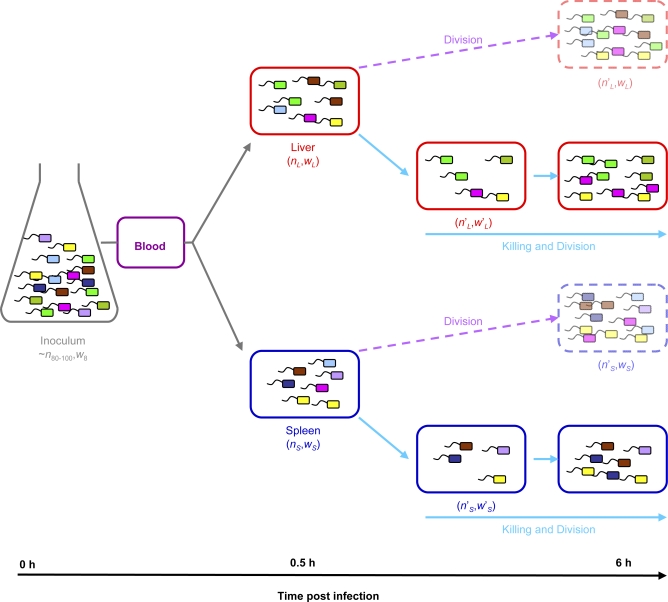
A Schematic Diagram Summarizing the Initial Dynamics of Systemic S. enterica InfectionsDuring the early stages of infection, bacteria move from the blood into the spleen and the liver (CFU in each organ denoted by nS and nL, respectively), representing a frequency of WITS in the spleen (wS) and liver (wL). WITS frequency at 0.5 h p.i. is consistent with stochastic removal of bacteria from the blood by the liver and spleen. Between 0.5 and 6 h p.i., bacterial growth and death occur in parallel, leading to the disappearance of individual subpopulations and the expansion of others. If bacterial death did not occur, the frequency of WITS per organ at 0.5 and 6 h would be comparable (dashed line and faded shading).